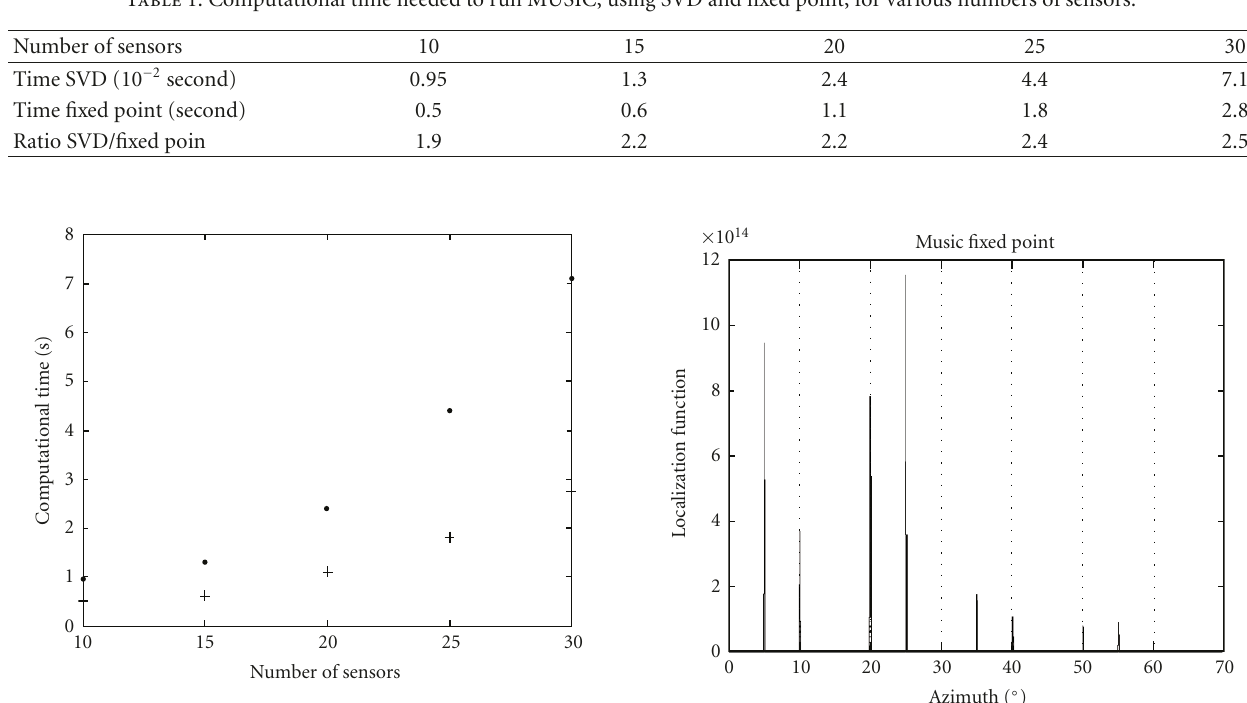
Figure 10: Computational time for MUSIC with SVD ( · ) and for MUSIC with fixed-point algorithm (+).